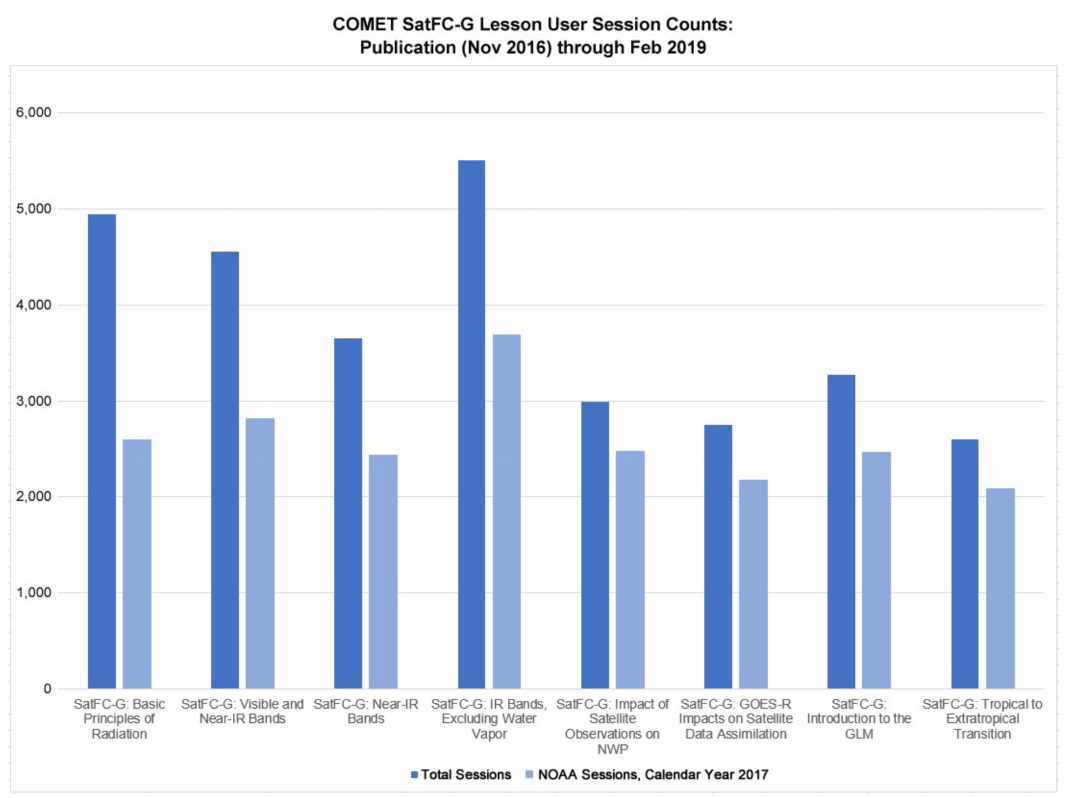
Figure 12. User session counts (through February 2019) for the eight SatFC-G lessons developed by COMET and published in 2016 prior to the GOES-R satellite launch. These lessons have received considerable use by meteorological services throughout the Americas, but particularly by NOAA’s US